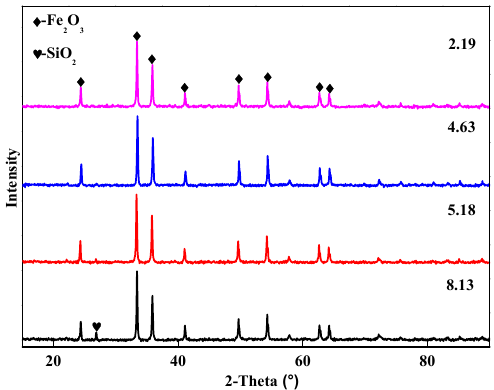
Figure 5. XRD analysis of pellets with different SiO 2 content.